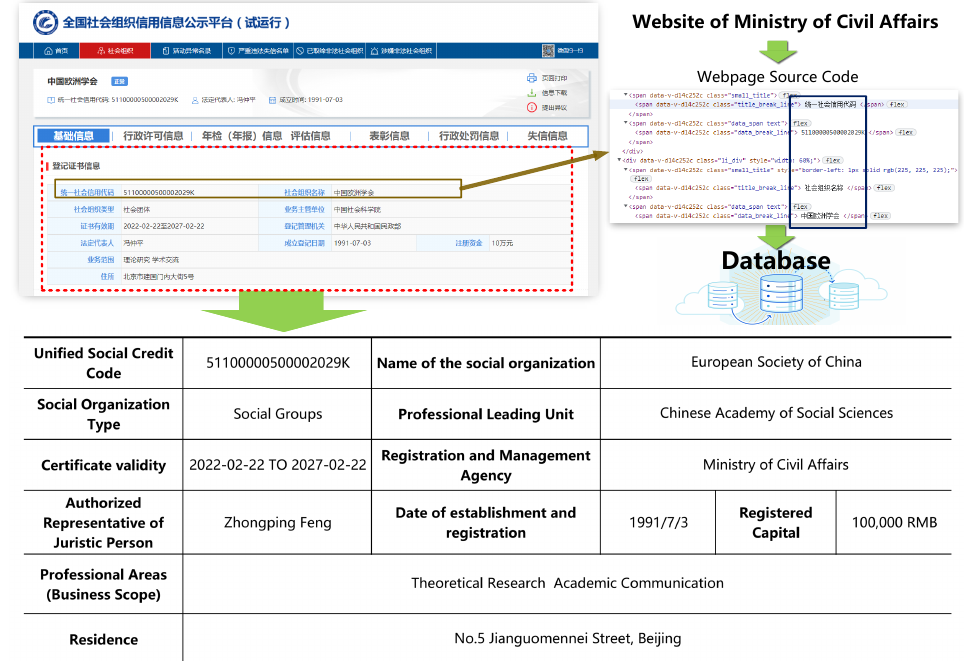
Figure 8. A flow chart showing the database construction based on open data platform of the Ministry of Civil Affairs of